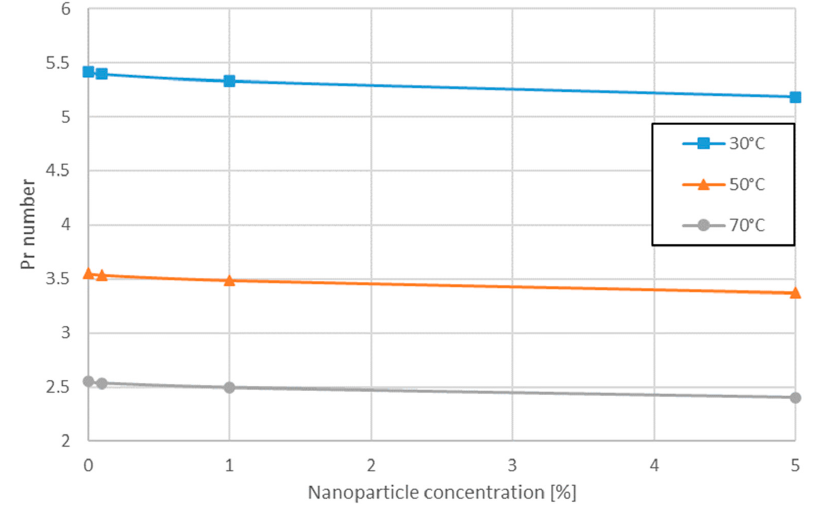
Figure 14. Variation of Pr number for water-Al 2 O 3 nanofluids.